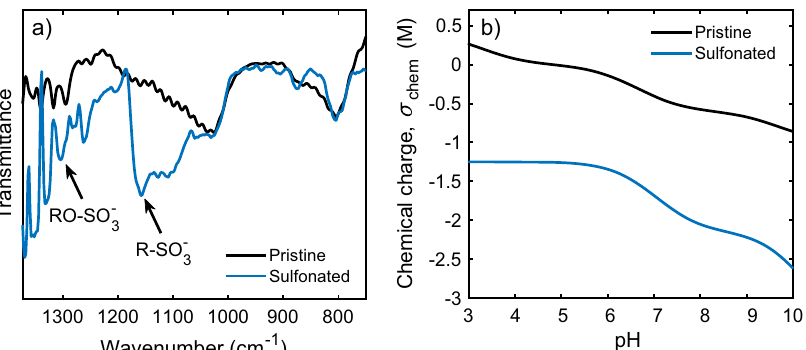
Fig. 3 Electrode characterization. a Measured transmission FTIR spectra for a pristine electrode and an electrode after sulfonation. b Measured nanopore chemical charge concentration, σ chem , of these electrodes determined from direct titration experiments.